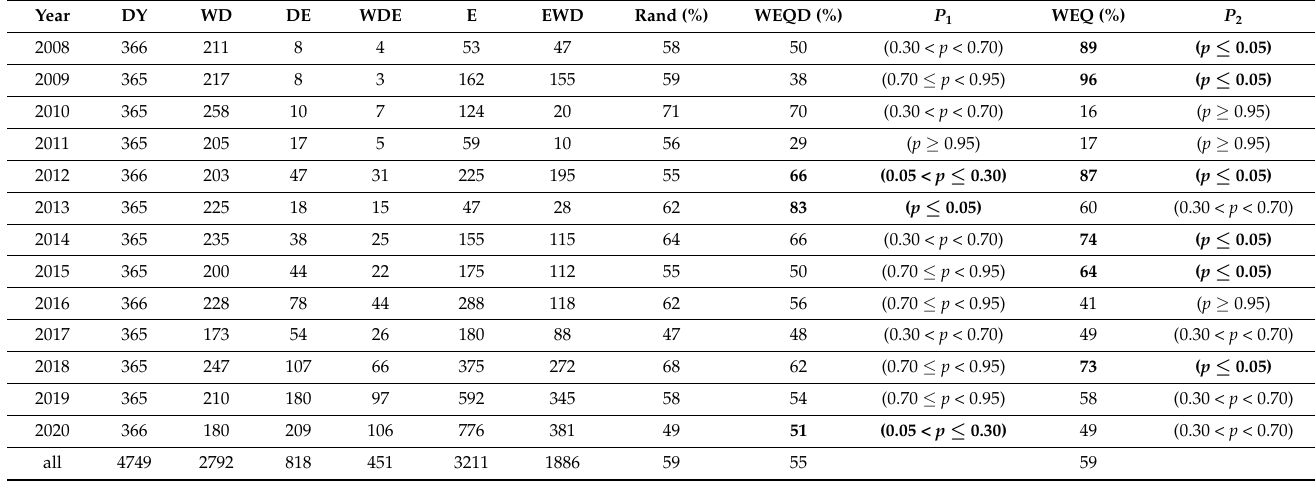
Table 2. Scenario #2, rain threshold R = 0.1 mm, memory τ = 1 day. The cases 0 < P ≤ 0.30 are highlighted in